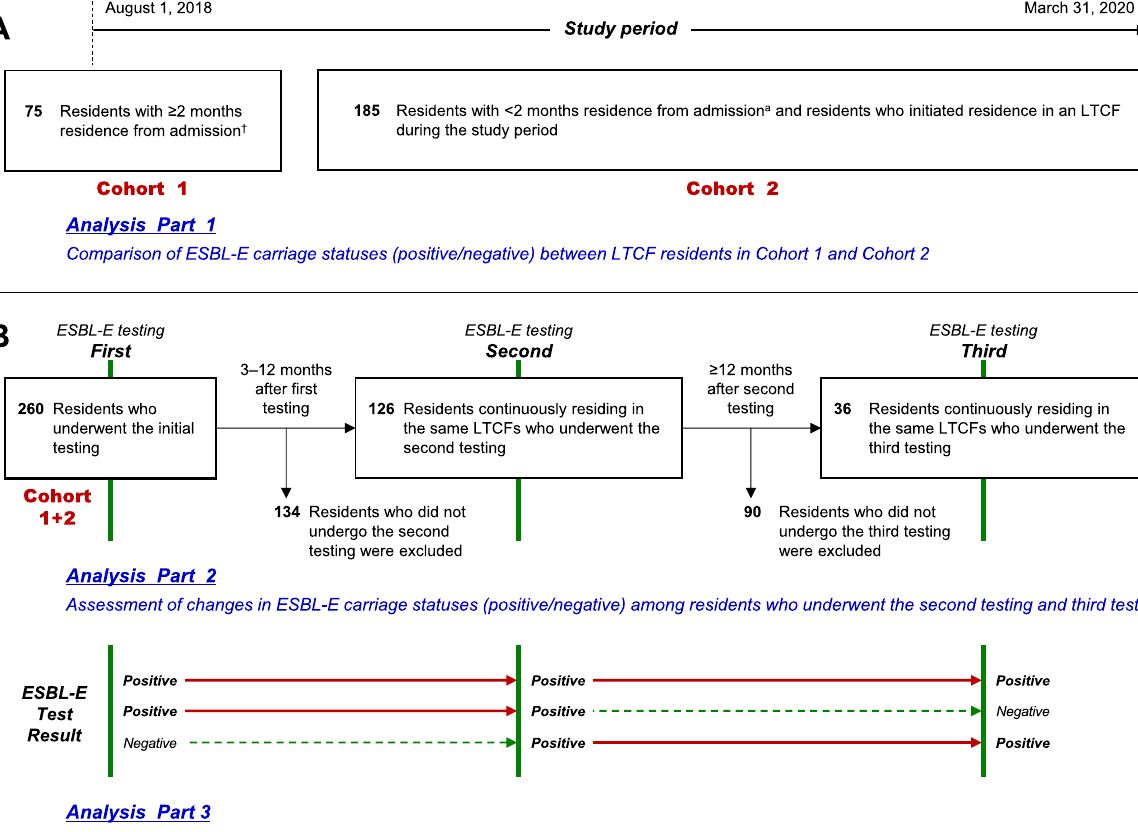
Figure 1. Study design and participants (N = 260). † At the start of the study. ‡ If all three tests revealed positive results, the lengths of ESBL-E carriage were measured from the first testing through third testing. LTCF, long- term care facility; ESBL-E, extended-spectrum β-lactamase-producing